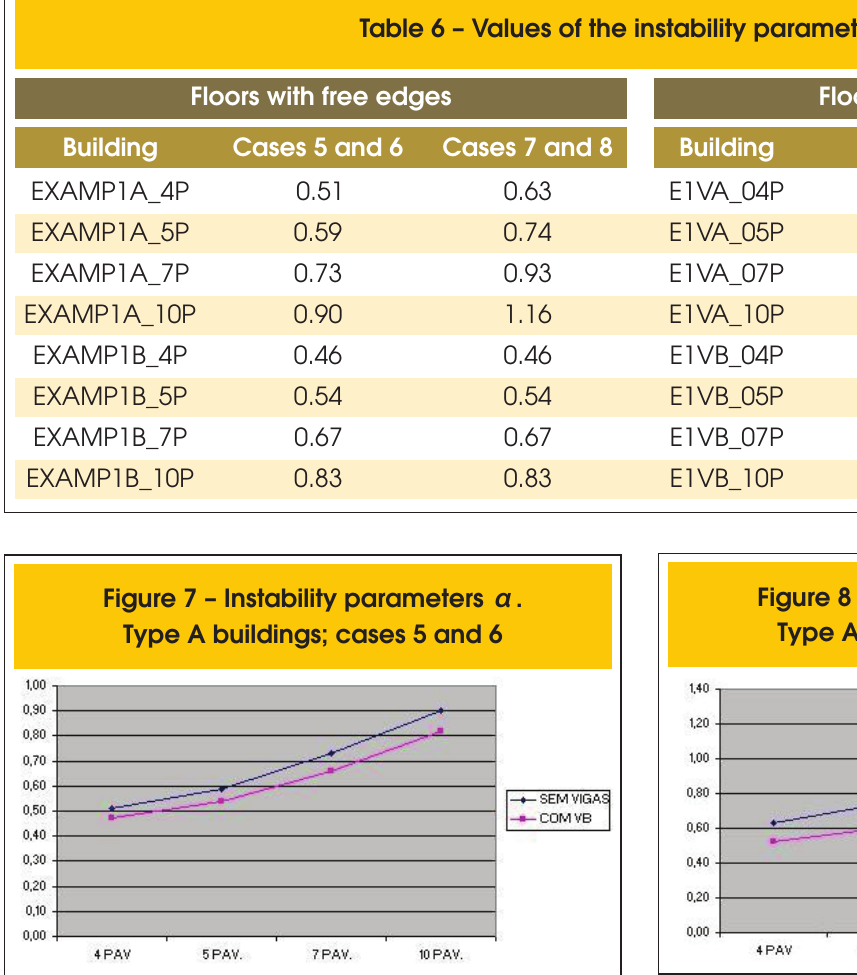
Table 6 – Values of the instability parameters α